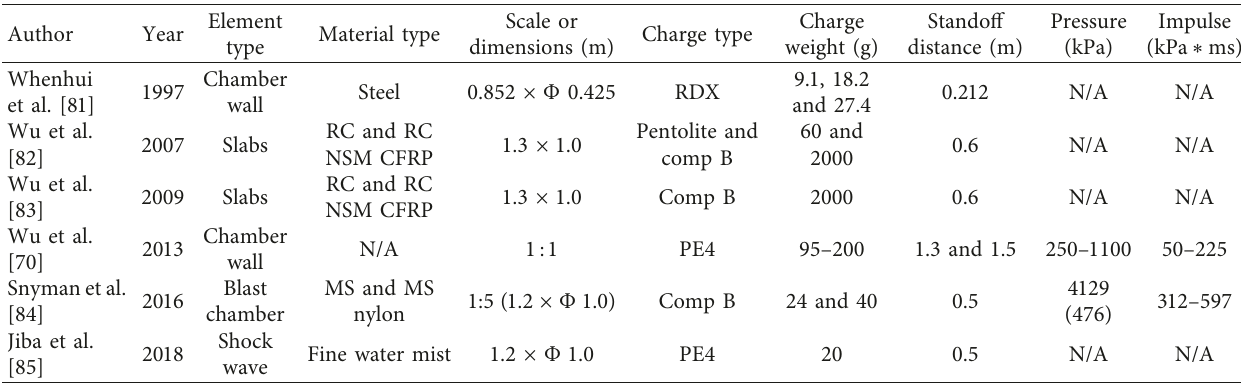
Table 5: Blast chamber tests.